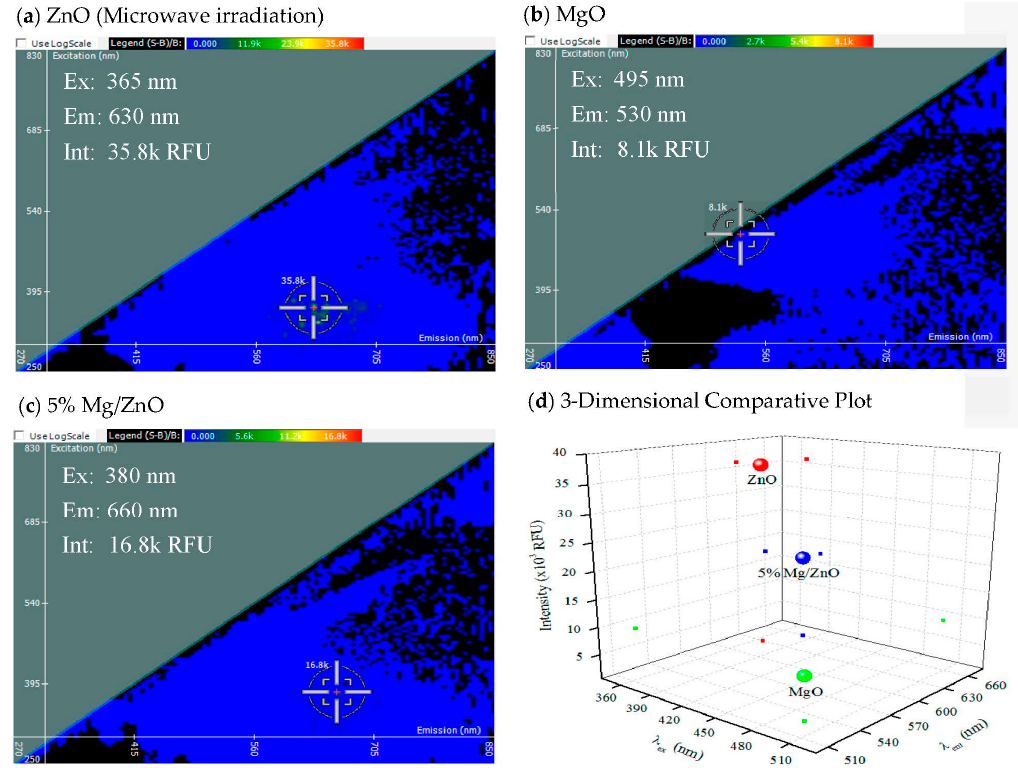
Figure 1. 2-D FDS of ( a ) zinc oxide nanoparticles (NPs) synthesized by microwave irradiation; ( b ) magnesium oxide nanoparticles; and ( c ) 5% magnesium with 95% zinc oxide; ( d ) Three-dimensional comparative plot of the three nanocomposites.